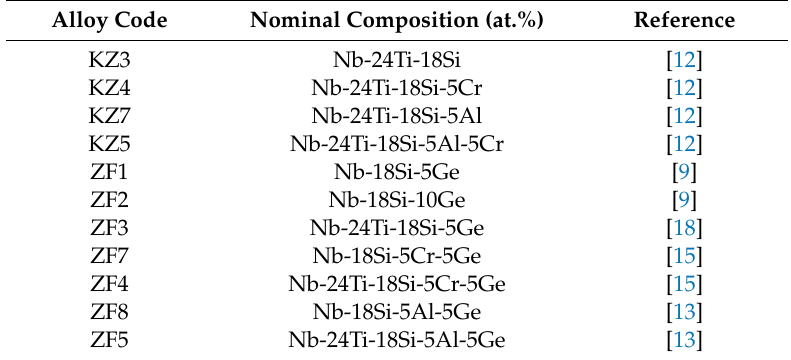
Table A1. Nominal compositions (at.%) of alloys that are referred to in this paper Alloy Code Nominal Composition